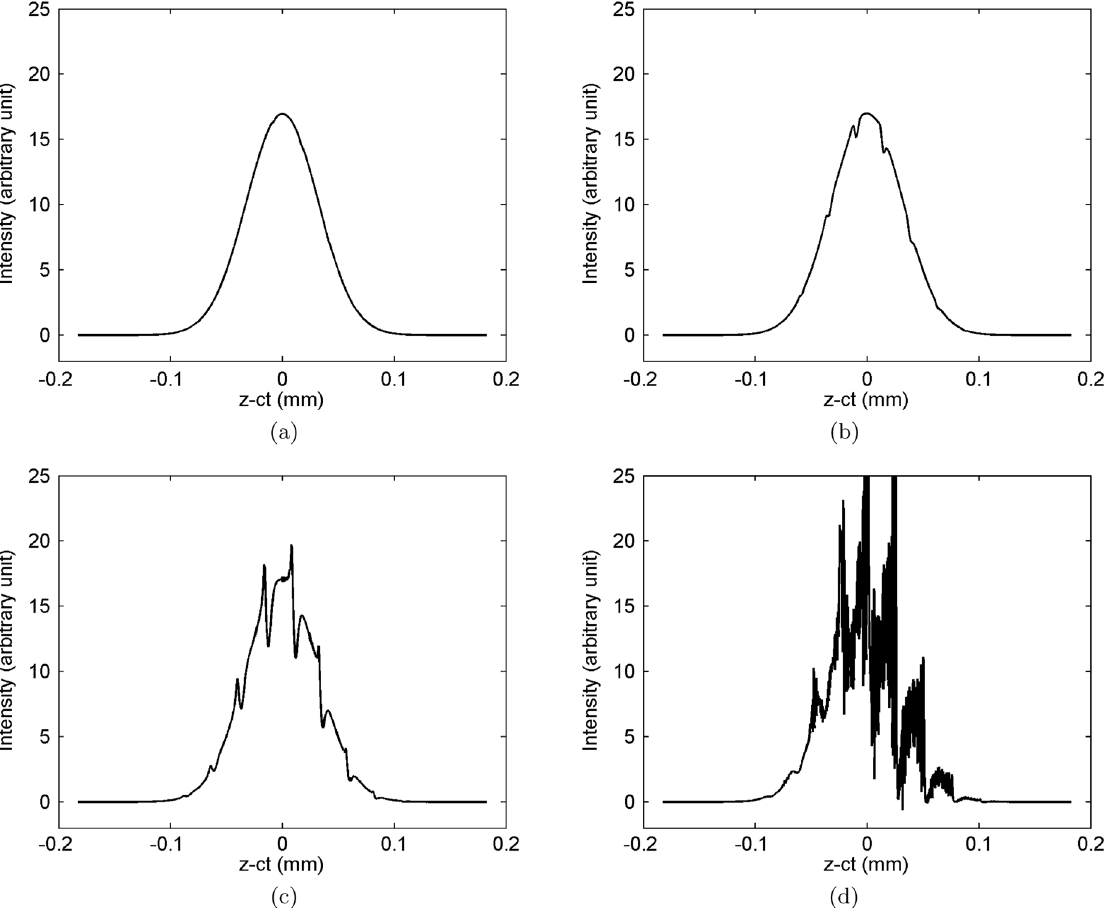
FIG. 7. Distribution of the laser intensity when the laser has propagated (a) 0.8 mm, (b) 1.9 mm, (c) 3.8 mm, and (d) 6.3 mm. The measurement only takes place from about − 0 . 1 mm to 0.1 mm relative to the center of the pulse. The last picture shows that the photon trapping occurs and causes intensity at some points go to